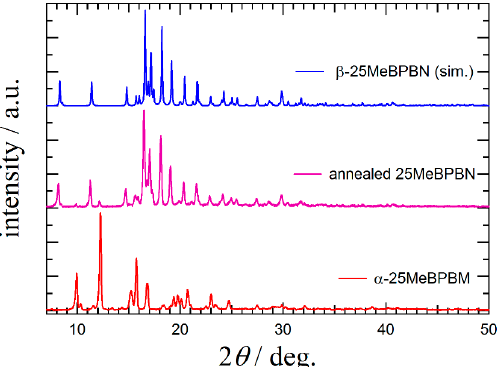
Figure 5. PXRD of three 25MeBPBN specimens; (bottom) α -25MeBPBN as synthesized, (middle) α -25MeBPBN after annealed (recovered after the SQUID thermal-cycle measurements (for details, see Figure 6a)), and (top) a simulation from the data of β -25MeBPBN (The simulation profile was calculated with the room temperature data of β -25MeBPBN as follows: Monoclinic, C 2/ c , a = 33.431(11), b = 6.092(2), c =22.342(11) Å, β = 112.24(4) ˚ , V = 4212(3) Å 3 , Z = 8, and d = 1.118 g cm − 3 at T = 296 K).